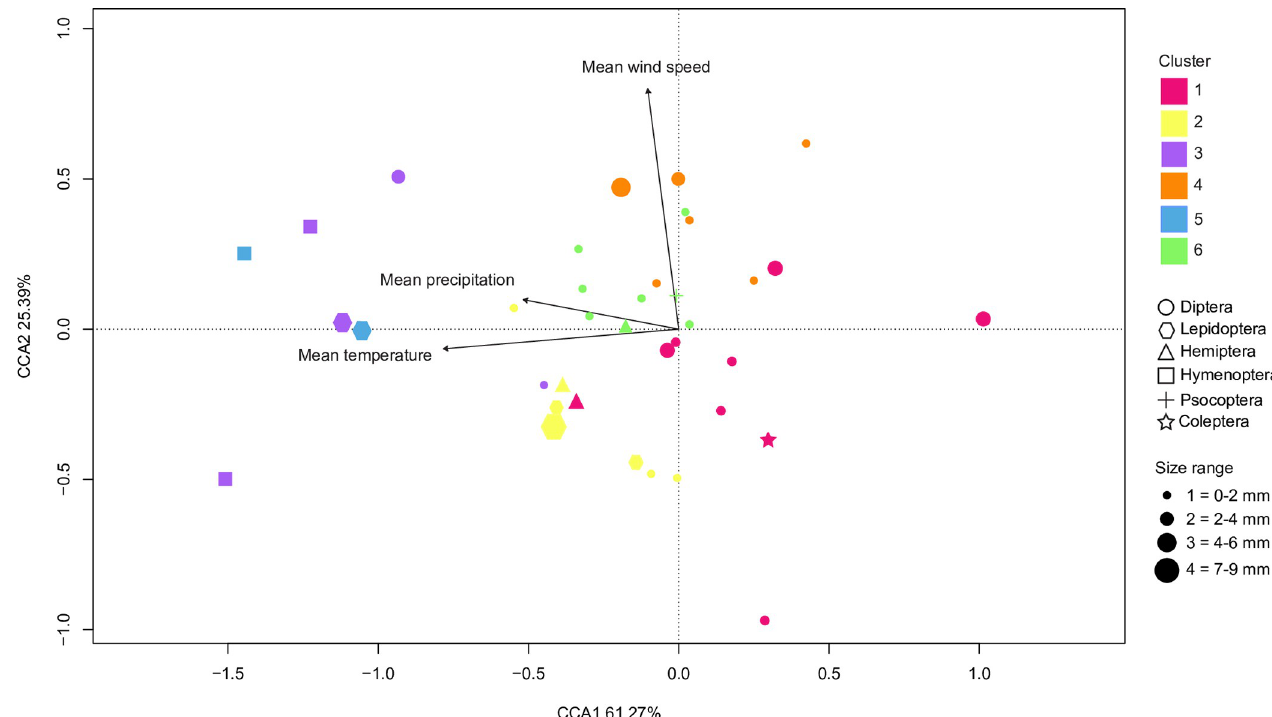
Fig 6. Canonical Correspondence Analysis (CCA) of the abundance distribution of BINs and the environmental variables. Arrows indicate the direction and magnitude of the effect of each environmental variable on the 38 most common BINs of the insect community.